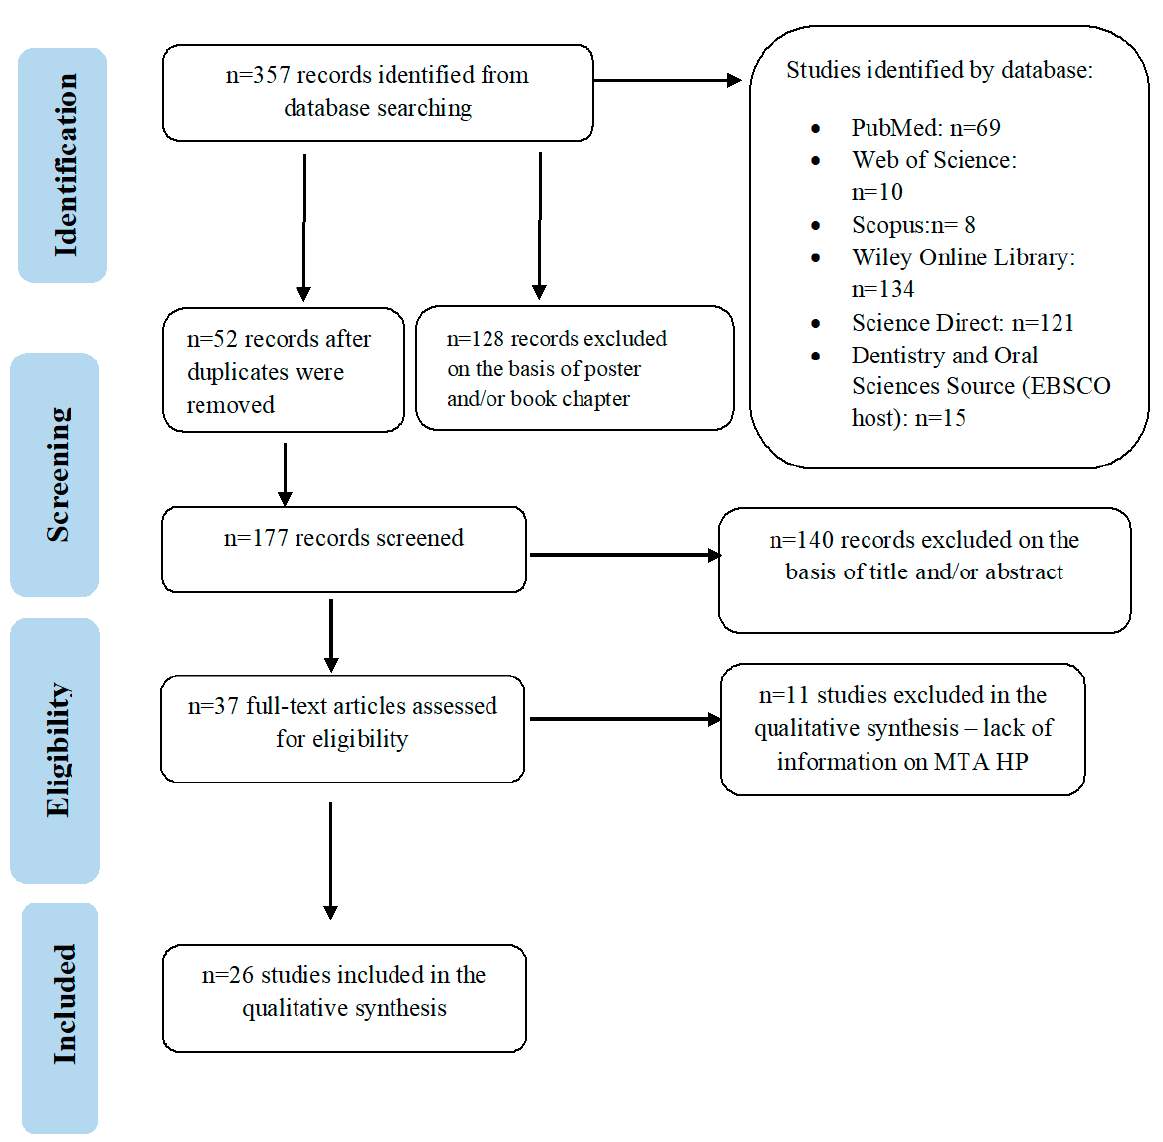
Figure 1. Search flow diagram compliant with PRISMA guidelines.